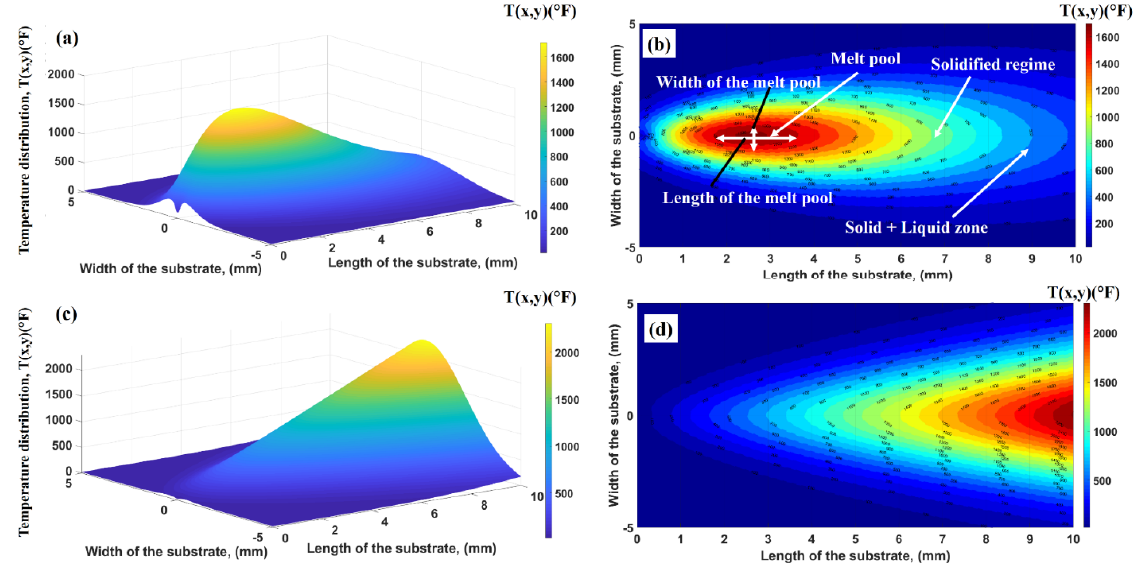
Figure 11. Three ‐ dimensional and contour thermal distributions within the powder bed ( a , b ) when the laser beam is at the starting point and ( c , d ) when the laser beam arrives at the end of the sub ‐ strate.